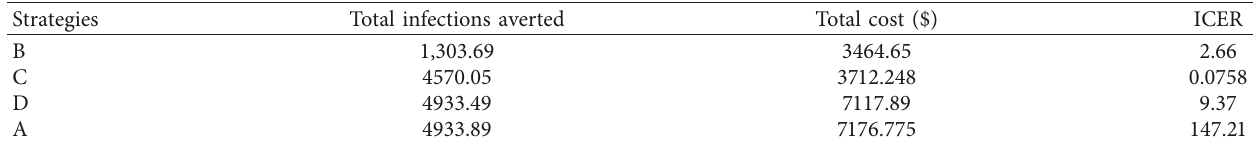
Table 3: Total amount of the infection averted and total cost with their